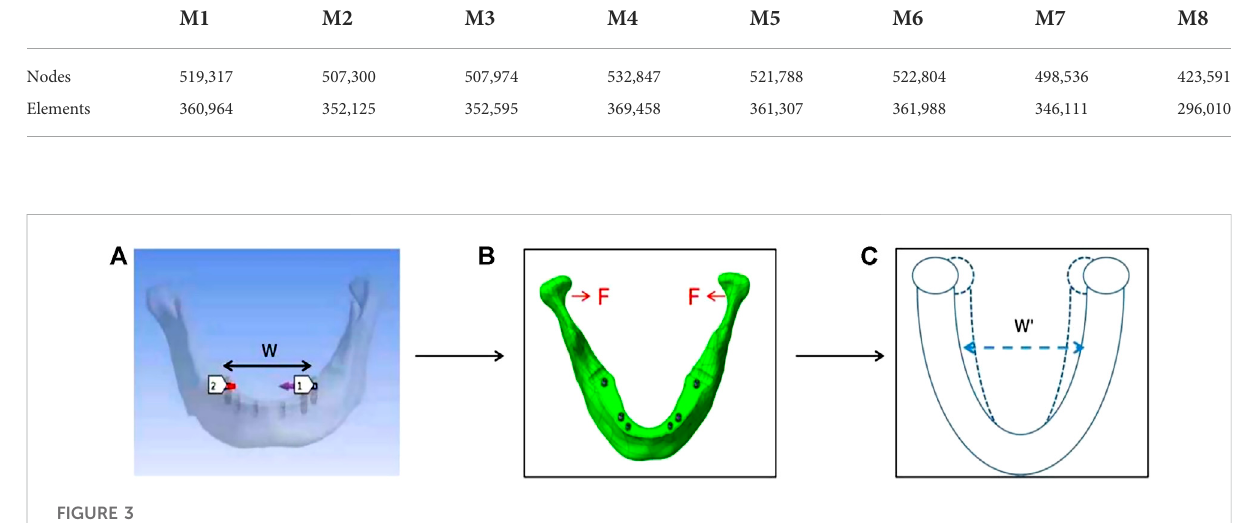
FIGURE 3 Methodofderivingloadingforcevalues,takingthebrachyfacialtype/maleasanexample. (A) Setthehorizontalpath p betweenthebilateral fi rst molars(between1and2inPanel3A)tomeasurethearchwidth. (B) Applythecohesiveforce (F) atthebilateralcondyles. (C) AdjustthevalueofFand measure the amount of displacement between the bilateral fi rst molars ( △ W); when Δ W equals 1.09 mm (X), the corresponding F value (41 N) was equivalent to the muscle strength of brachyfacial type/male.